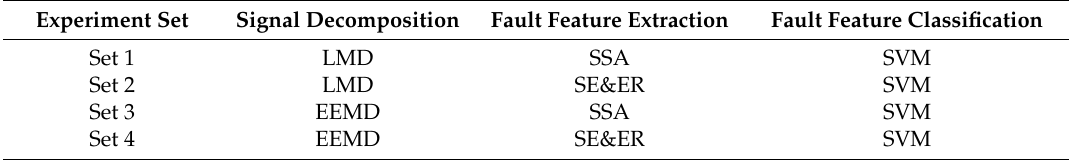
Table 1. Arrangement of experiments.